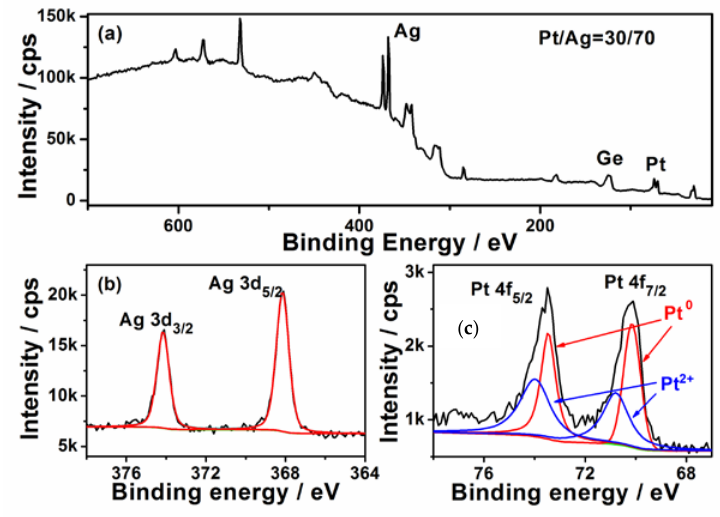
Figure 2. ( a ) XPS survey spectrum of Ag–Pt NPs/Ge; ( b , c ) the high solution XPS spectra of Ag 3d and Pt 4f.